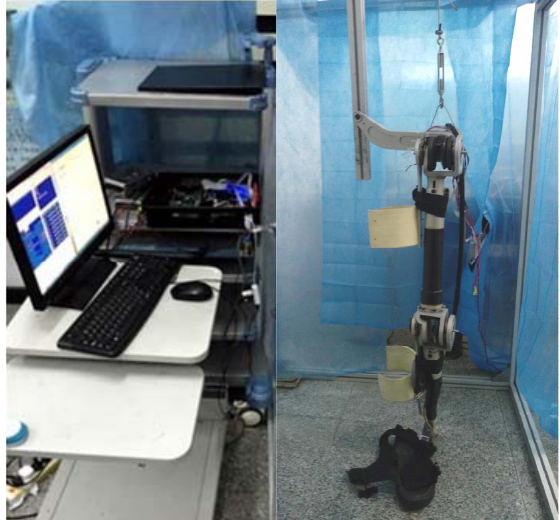
Figure 8. Exoskeleton robotic platform. The safety concern for our pilot is from two aspects, i.e., hardware precaution, as well as programming. Accordingly, exceeding of the motion is prohibited by the mechanical limit, and the system will be shut down if an error